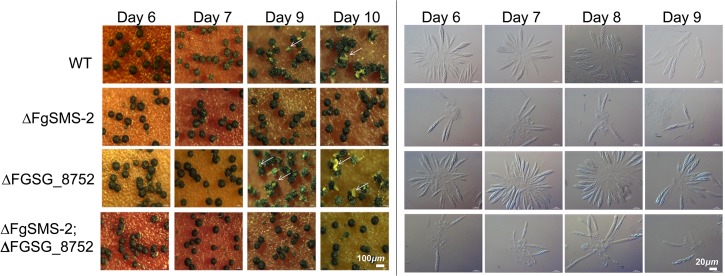
Perithecia formation and ascus/ascopore development in the single gene deletion- (ΔFgSMS-2 and ΔFGSG_08752, respectively) and double gene deletion-strains (ΔFgSMS-2;ΔFGSG_8752) grown on carrot agar.WT: F. graminearum wild-type Z3643 strain. The perithecia formed 6, 7, 9, or 10 days after perithecia induction, and the asci and ascospores that developed within a perithecium were observed through a dissecting microscope (left panels) and differential interference contrast microscope (right panels), respectively. The exuded spore masses called cirrhi from the perithecia in the wild-type and ΔFGSG_08752 strains were indicated by arrows. Scale bars = 100 μm for perithecia and 20 μm for asci/ascospores.